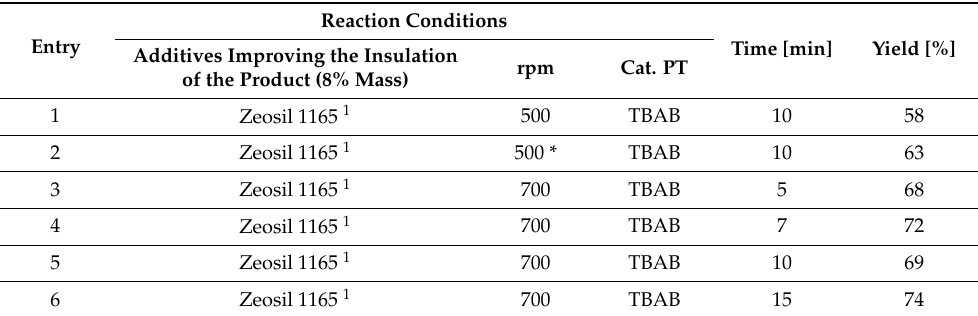
Table 4. Synthesis of aripiprazole in the presence of potassium carbonate and catalysts PTC in a